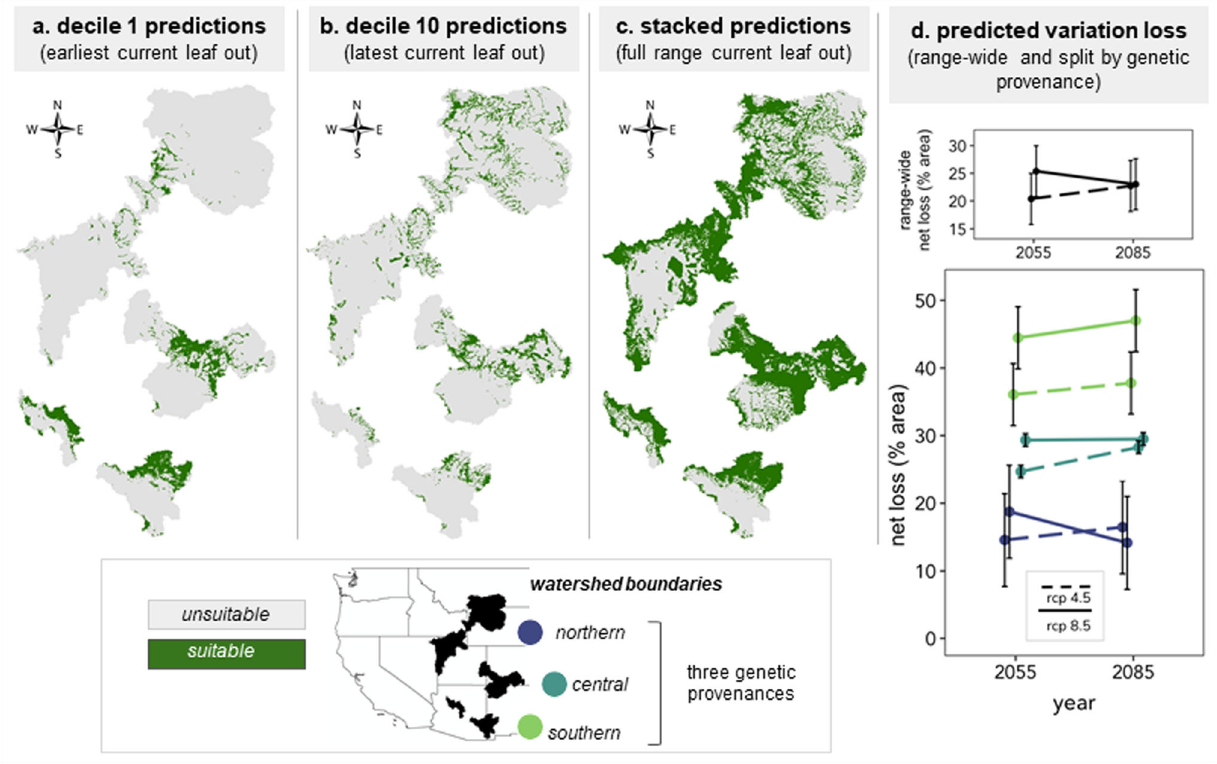
Fig. 1 Maps of leaf out decile 1, leaf out decile 10, stacked deciles 1 through 10 as binary (presence-absence) predictions on current climate; Percent of the landscape predicted to lose phenological trait variation across three genetic provenances, two future time periods (2055, 2085), and two relative concentration pathways (RCP 4.5 and RCP 8.5). In a – c , shapes represent watershed designations for each genetic provenance, as described in the U.S. map; green represents suitable climatic conditions for the modeled trait decile (or deciles) and gray represents unsuitable climatic conditions for the modeled trait decile (or deciles). In d , “ net ” percent loss is calculated as the difference between percent loss and percent gain. Points ( + / − standard error bars) represent average predictions from three Atmosphere and Ocean General Circulation/Climate models (AOGCMs) that capture “ best ” , “ worst ” , and “ median ” climate projections for this geographic region. Color represents genetic provenance of P. angustifolia , as labeled in c . Yellow green represents the southern provenance, green blue the central provenance, and blue purple the northern provenance. Line type (dashed or solid) represent RCP 4.5 and 8.5 respectively. For visual clarity, this map does not show occurrence data. These data, with latitudes and longitudes, can be found in the supplementary information. Table 1 Net loss of foliar phenology trait variation calculated as percent loss minus percent gain and 95 percent con fi dence bounds averaged for the three global circulation models across geographic range (genetic provenance), year, and relative concentration pathway